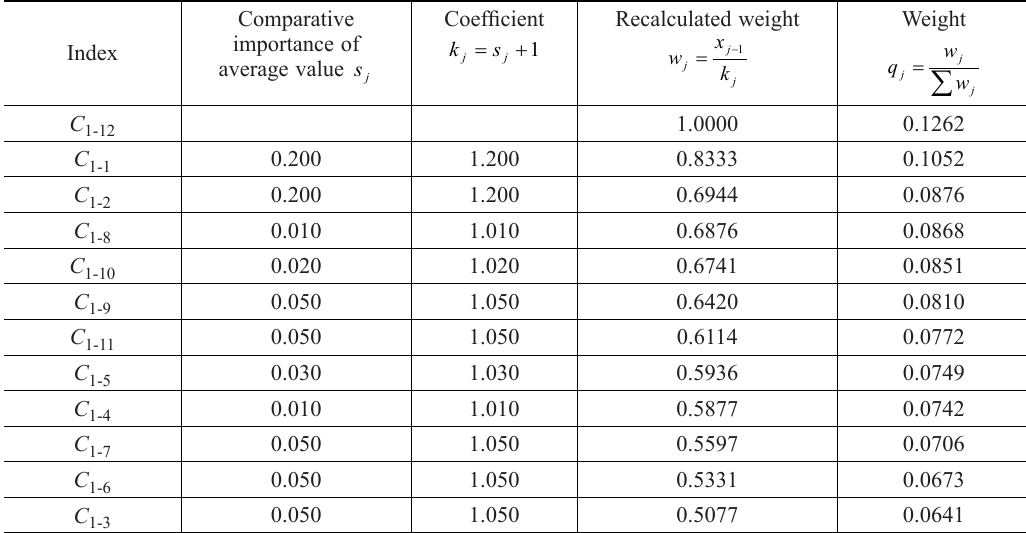
Table 5. Priorities and final weights of sub-indexes reflecting the capability of reducing blast effect